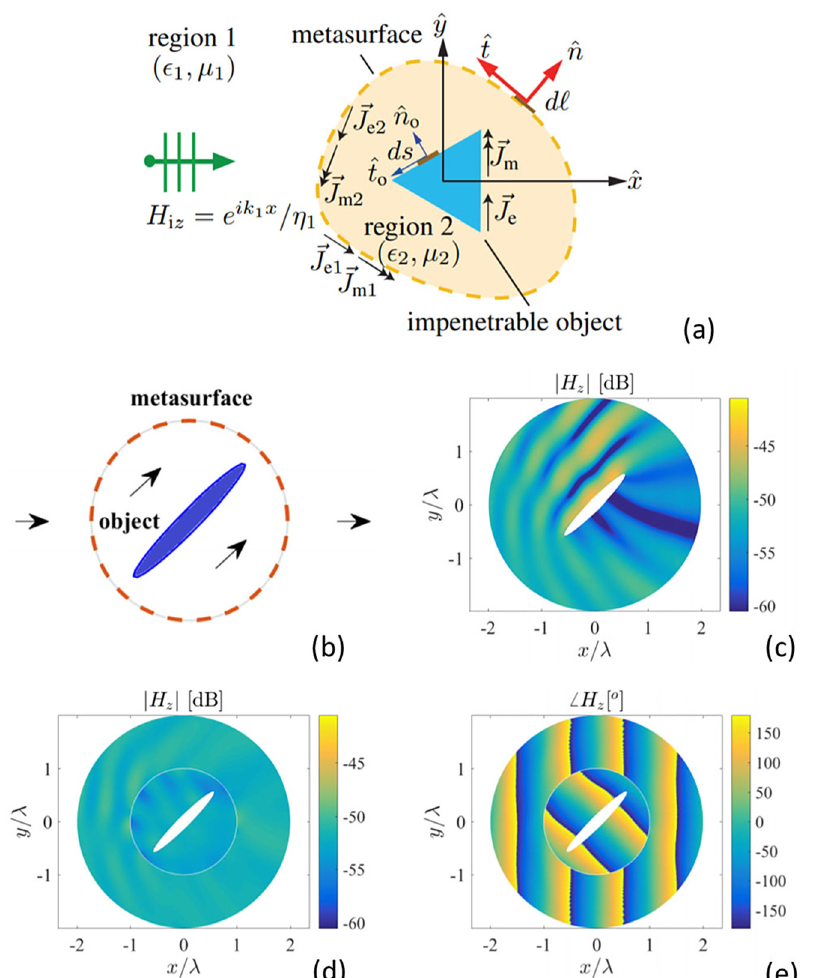
each separated by dielectric spacers as seen in Figure 26a. The cylindrical metasurface is designed such that the TE z modes created by the electric line source placed at the center of the geometry (Figure 26b) are completely con- verted to TM modes at the output (Figure 26c). The au- z thors also report polarization splitters which split half of the incident power to TE waves and half to TM waves. z z